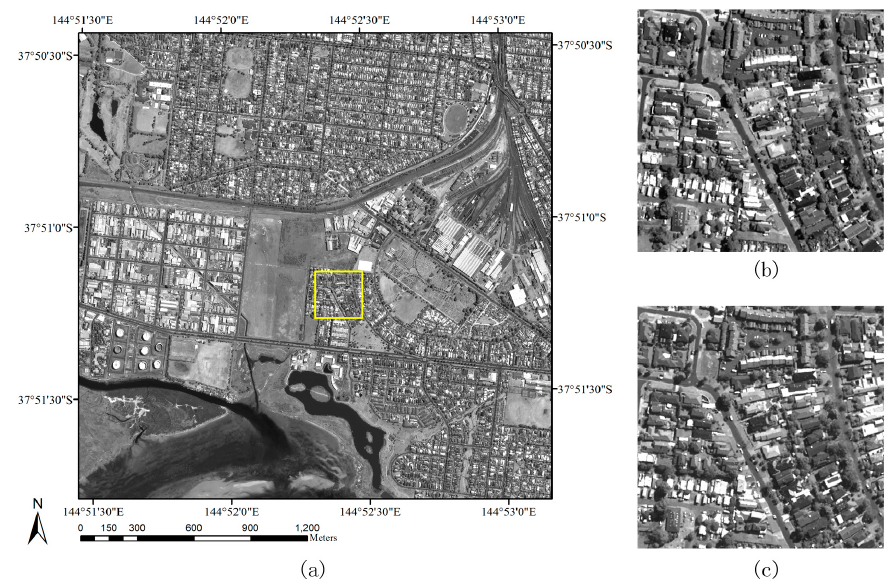
Figure 8. Images of stereo pair 1. ( a ) Image 1 of the stereo pair as a whole. ( b , c ) A detail view of the yellow rectangle seen in ( a ) in Image 1 and in Image 2, respectively.